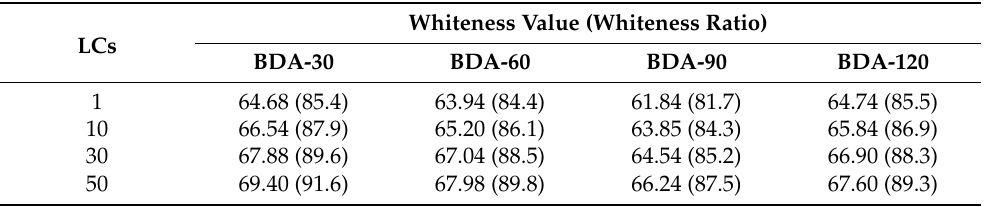
Table 7. The whiteness values treated samples with different laundering cycles (3 curing